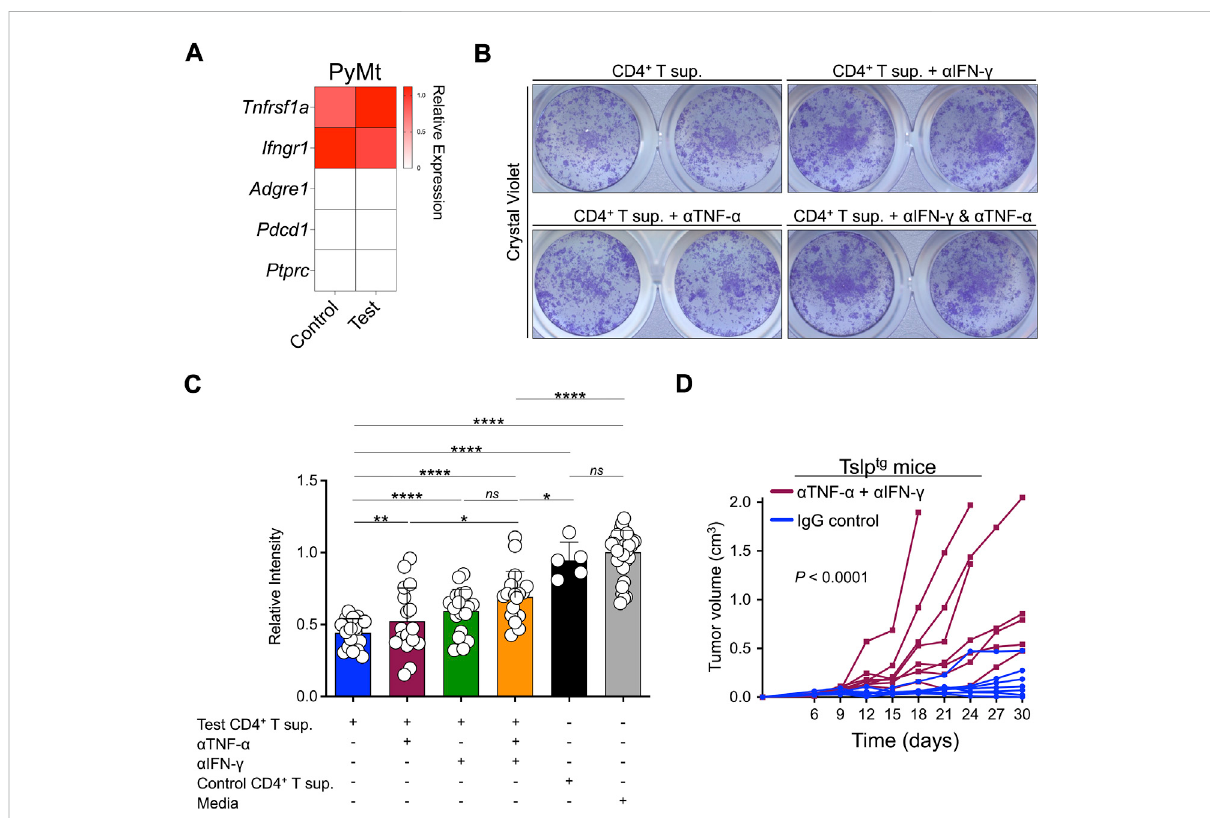
FIGURE 4 TNF- α and IFN- γ contribute to TSLP-activated antitumor immunity against advanced breast cancer. (A) The transcriptome analysis for TNF- α and IFN- γ receptors expression in PyMt cells treated with TSLP-activated WT CD4 + T cell supernatant (sup.) (test, n = 6) and Tslpr KO CD4 + T supernatant(control, n =4). Adgre1 , Pdcd1 and Ptprc areimmunecell-relatedgenesthatareshownasnegativecontrols.Theheatmapdemonstrates the ratio between mean fragments per kilobase of transcript per million mapped reads (FPKM) value of each group and the average of mean FPKM values ofthetwogroups. (B) Representative images of2Dproliferation assay withcrystal violet stainingofPyMt cellline culturewith testCD4 + T supernatant (top left), test CD4 + T supernatant + anti-IFN- γ blocking antibody (top right), test CD4 + T supernatant + anti-TNF- α blocking antibody (bottom left), and test CD4 + T supernatant + anti-IFN- γ and anti-TNF- α combined (bottom right). (C) Quanti fi cation of crystal violet-stained PyMt cellsculturedintestCD4 + Tcellsupernatant( n =10),testCD4 + Tsupernatant+anti-IFN- γ blockingantibody( n =19),testCD4 + TSup+anti-TNF- α blockingantibody( n =17),testCD4 + TSup+anti-TNF- α andanti-IFN- γ combined( n =18),controlCD4 + Tsupernatant ( n =5)andmediaalone( n = 36). Relative intensity of crystal violet stain in each well is determined using ImageJ (*: p < 0.05, **: p < 0.01, ***: p < 0.001, ****: p < 0.0001, ns :